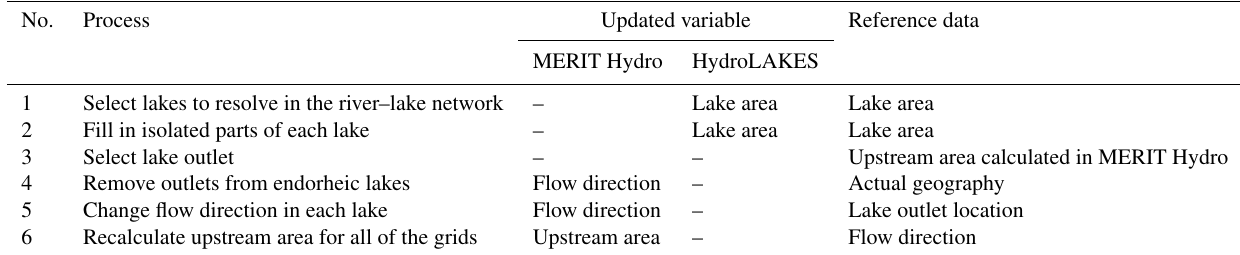
Table 1. Summary of the harmonization of geographical information from MERIT Hydro and HydroLAKES. All processes except number 4 are automated.